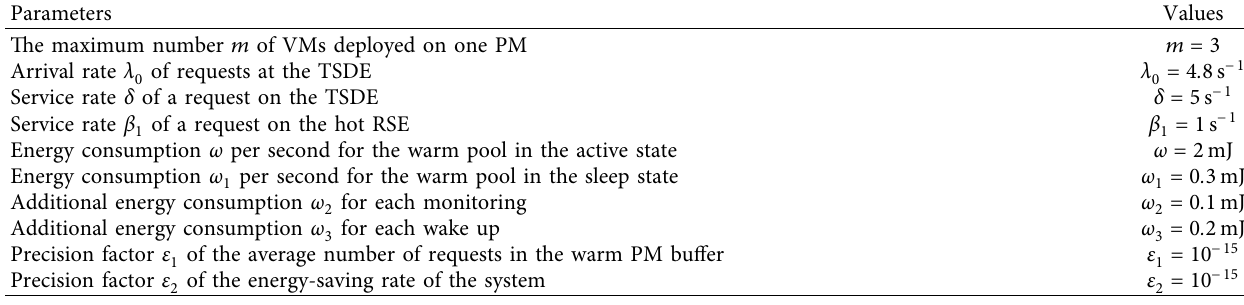
Table 2: Parameter settings in the experiments.